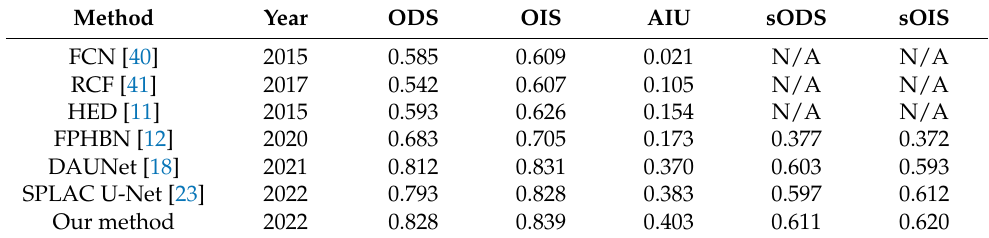
Table 4. Segmentation performance comparison results on CFD dataset.